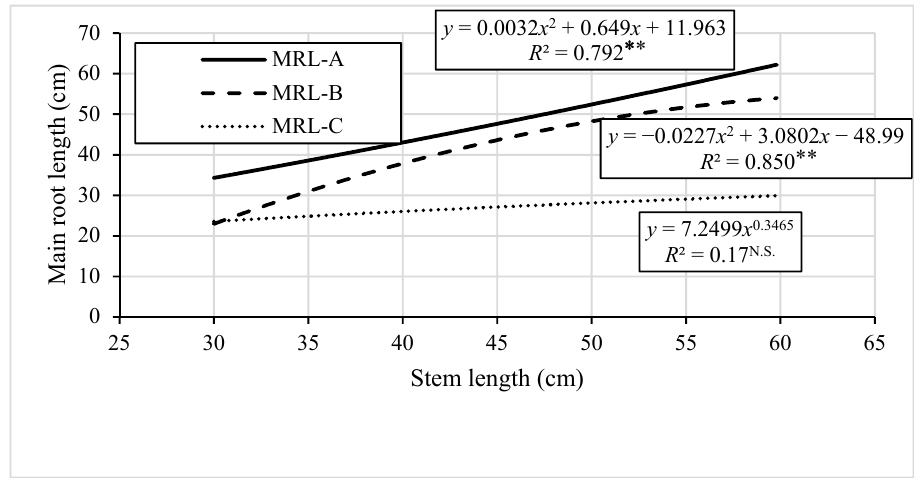
Figure 4. Relationship between stem length and main root length of maple seedlings in three areas